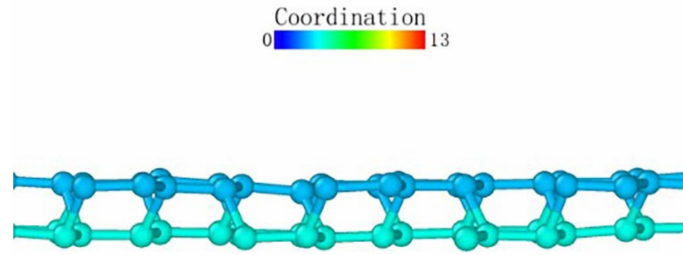
Figure 16. The upper boundary atomic structure before loading.